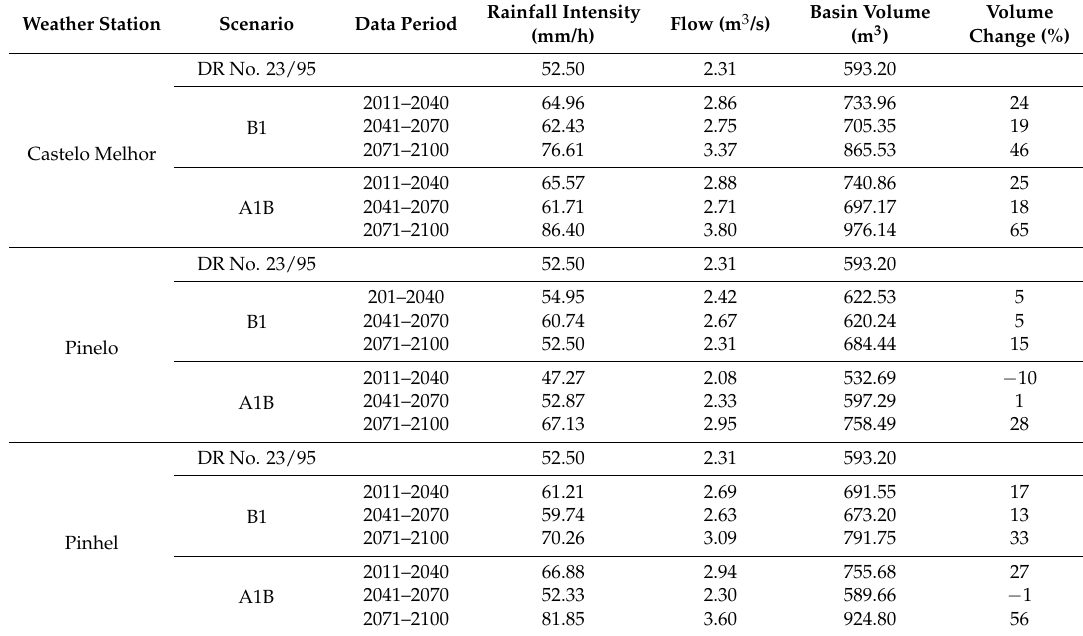
Table 4. Differences in the size (relative volume change) of the retention basin for the rainfall region B, recurring to the rainfall intensity estimated with the Regulation-decree No. 23/1995 [19] (“Decreto Regulamentar No. 23/95”, DR No. 23/95 in Portuguese) and simulated data for periods of thirty years for the two future scenarios (A1B and